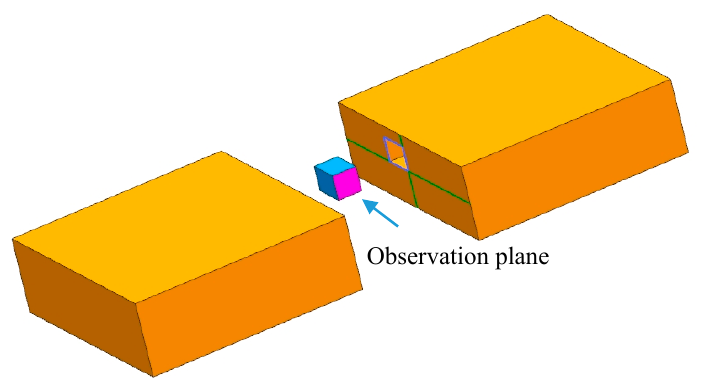
Figure 1. Sketch of metallographic specimens cutting from the cross section of ingot (the pink surface was the observation surface).